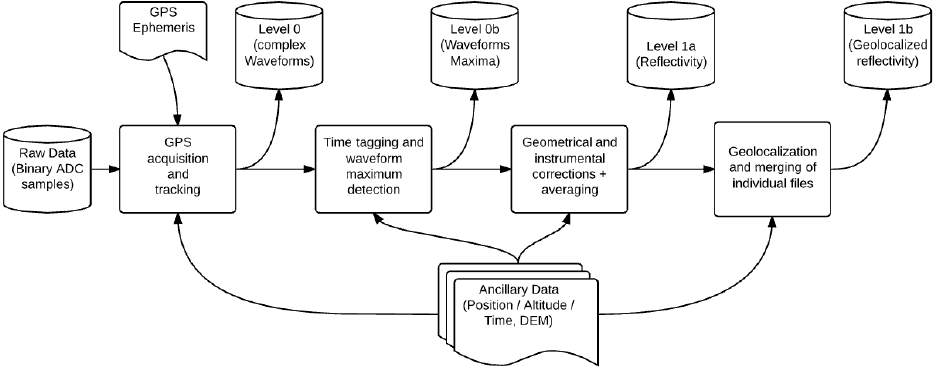
Figure 3. GLORI processing chain block diagram.